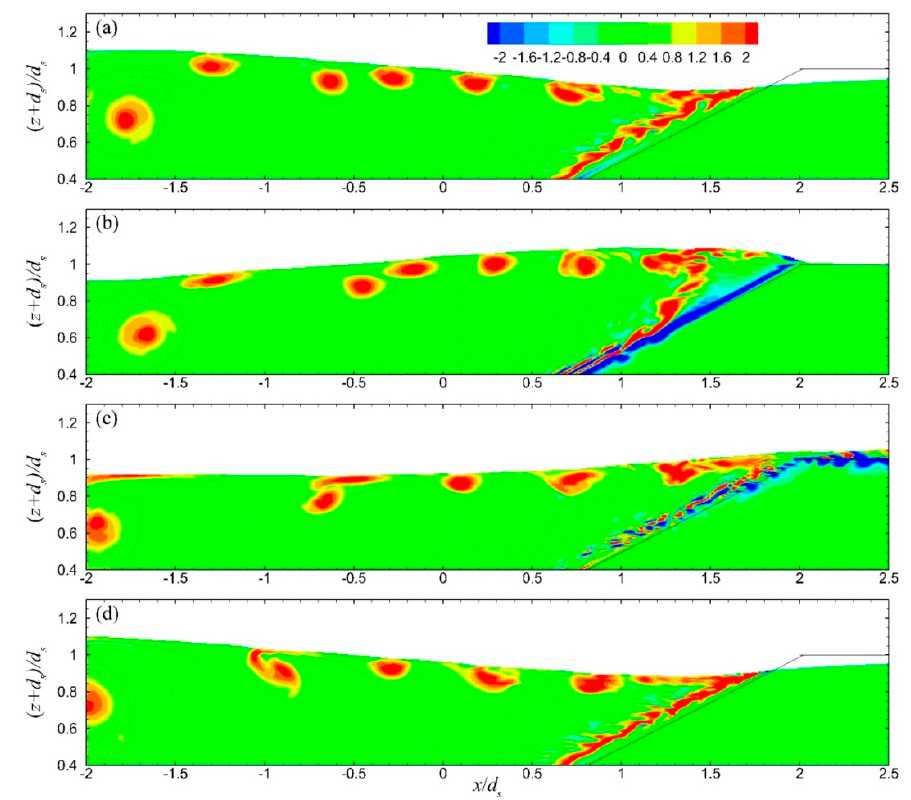
Figure 7. Vorticity field in the seaward region of ZFB case 1 at four instants during the 30th wave period: ( a ) T / 3, ( b ) 3 T / 8, ( c ) 5 T / 8, and ( d ) T